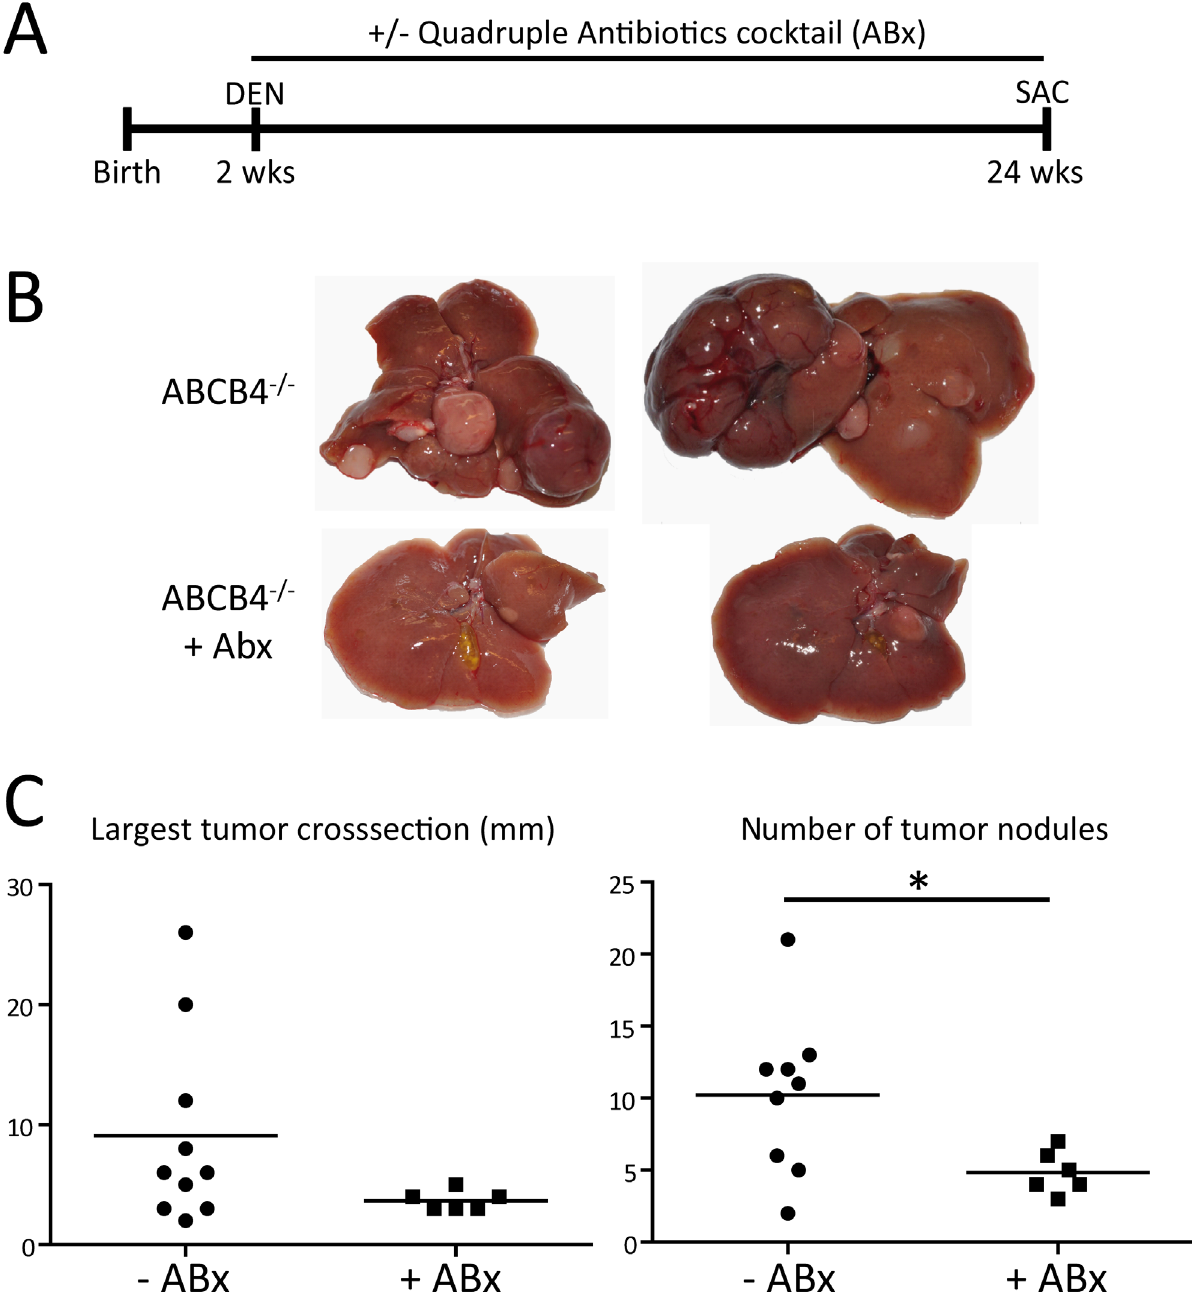
Fig 5. Gut sterilization leads to reduced tumor growth. ABCB4-deficient mice underwent DEN treatment and received a combination of four antibiotics (Abx) in drinking water until sacrifice (SAC). (A) Experimental design. (B) Macroscopic appearance of livers from ABCB4-deficient mice with or without Abx treatment. (C) Tumor sizes and numbers in the two experimental groups (-ABx: n = 10; +ABx: n = 6). * p <